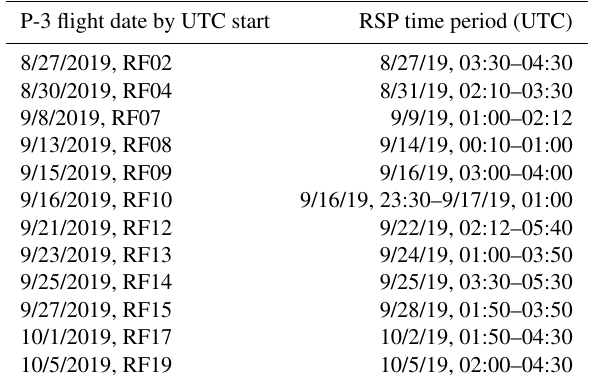
Table 4. The time periods of 12 research flights used to construct the analysis shown in Fig.